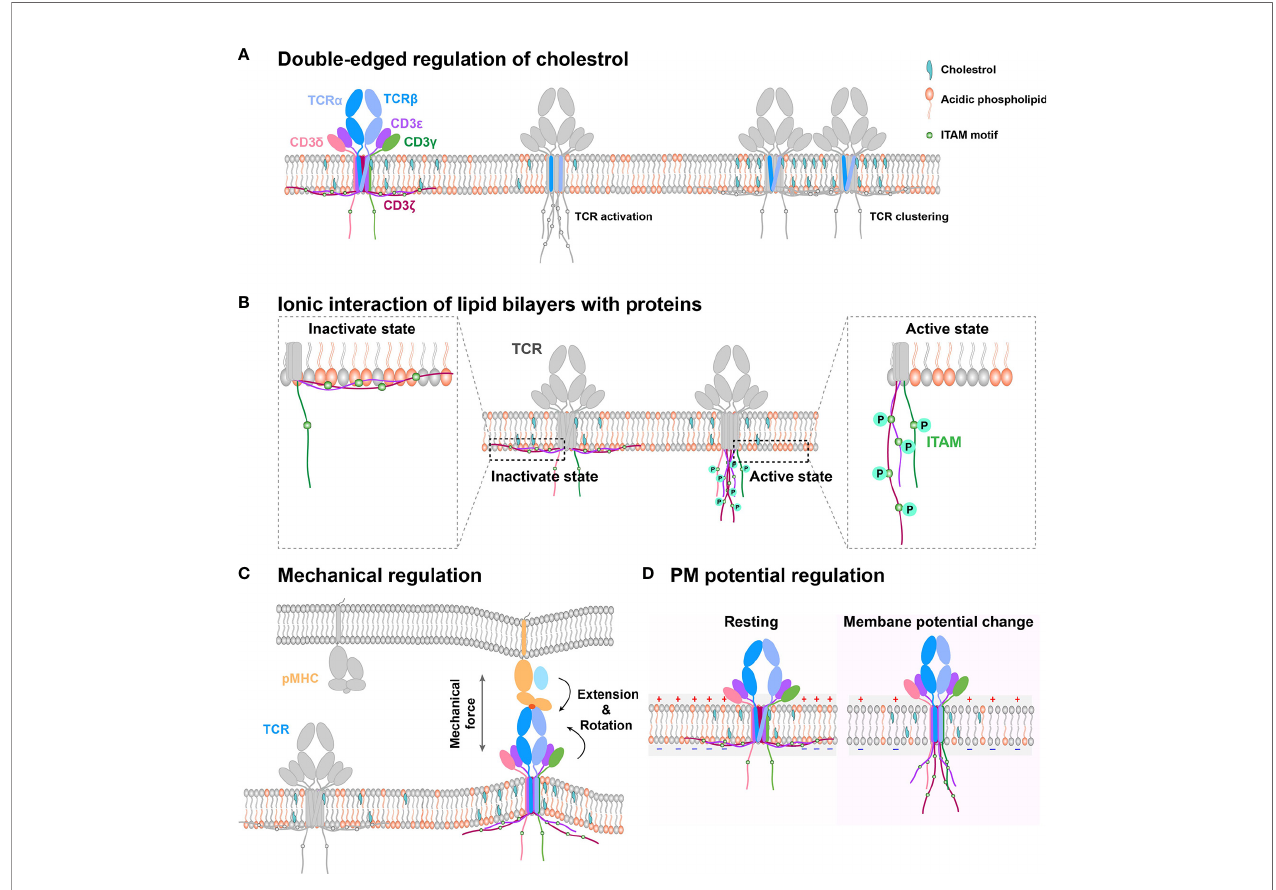
FIGURE 1 | Schematic models of PM regulation on TCR complex signaling. (A) Double-edged regulation of cholesterol on TCR activation. Cholesterol could directly bind with the TMD of the TCR b chain to keep TCR in an inactive state in the resting T cell. Cholesterol disassociation from the TCR b chain can switch the TCR complex to the activation state. Meanwhile, cholesterol also indirectly mediates TCR clustering, following TCR initial activation. (B) The interaction between negatively charged lipid and basic motif regulates CD3 ITAM motif exposure. TCR cytoplasmic domains contain polybasic regions, which directly interact with the negatively charged lipid in the membrane inner lea fl et to embed the ITAM motif in hydrophobic core of the PM in resting cell. The disruption of this interaction can expose the signaling motif to amplify downstream signaling. (C) PM provides a platform to sense outside cues for immune receptors. On this platform, mechanical force regulates TCR/pMHC recognition through conformation change. (D) Electrical potential might directly trigger TCR signaling. Since TCR TMD contains several charged residues, PM potential depolarization might induce TMD titling conformation to further allosterically regulate dissociation of CD3 tails from inner lea fl et and activate intracellular downstream